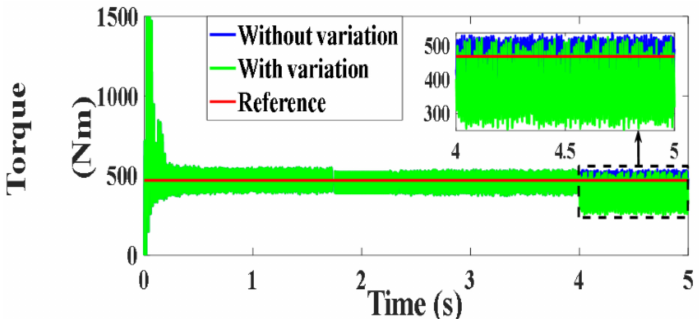
Figure 141. Developed torque under PVC (Nm).